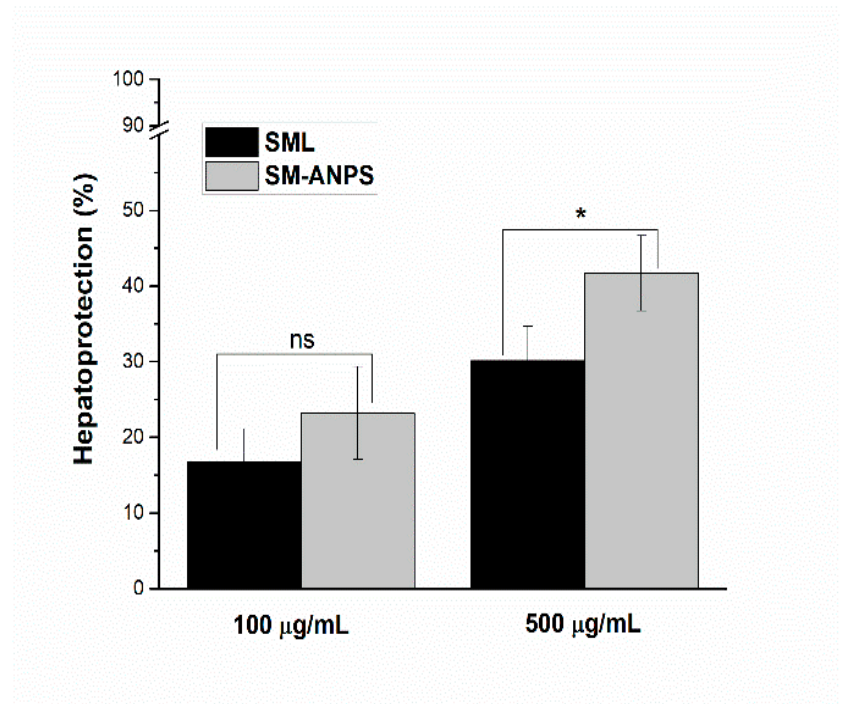
Figure 6. Hepatoprotective effect of SML-ANPs on rat hepatocytes in comparison to free SML so- lution, measured by the MTS assay. * p < 0.05 and ns when no significant difference was found between the SML group and the SML-ANPs group. Results presented as %hepatoprotection and expressed as the mean ± SD (n in each group = 4).